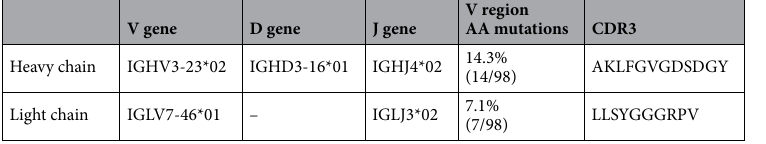
Table 5. Immunogenetic analysis of 3G9. The closest germline genes were determined using the IMGT